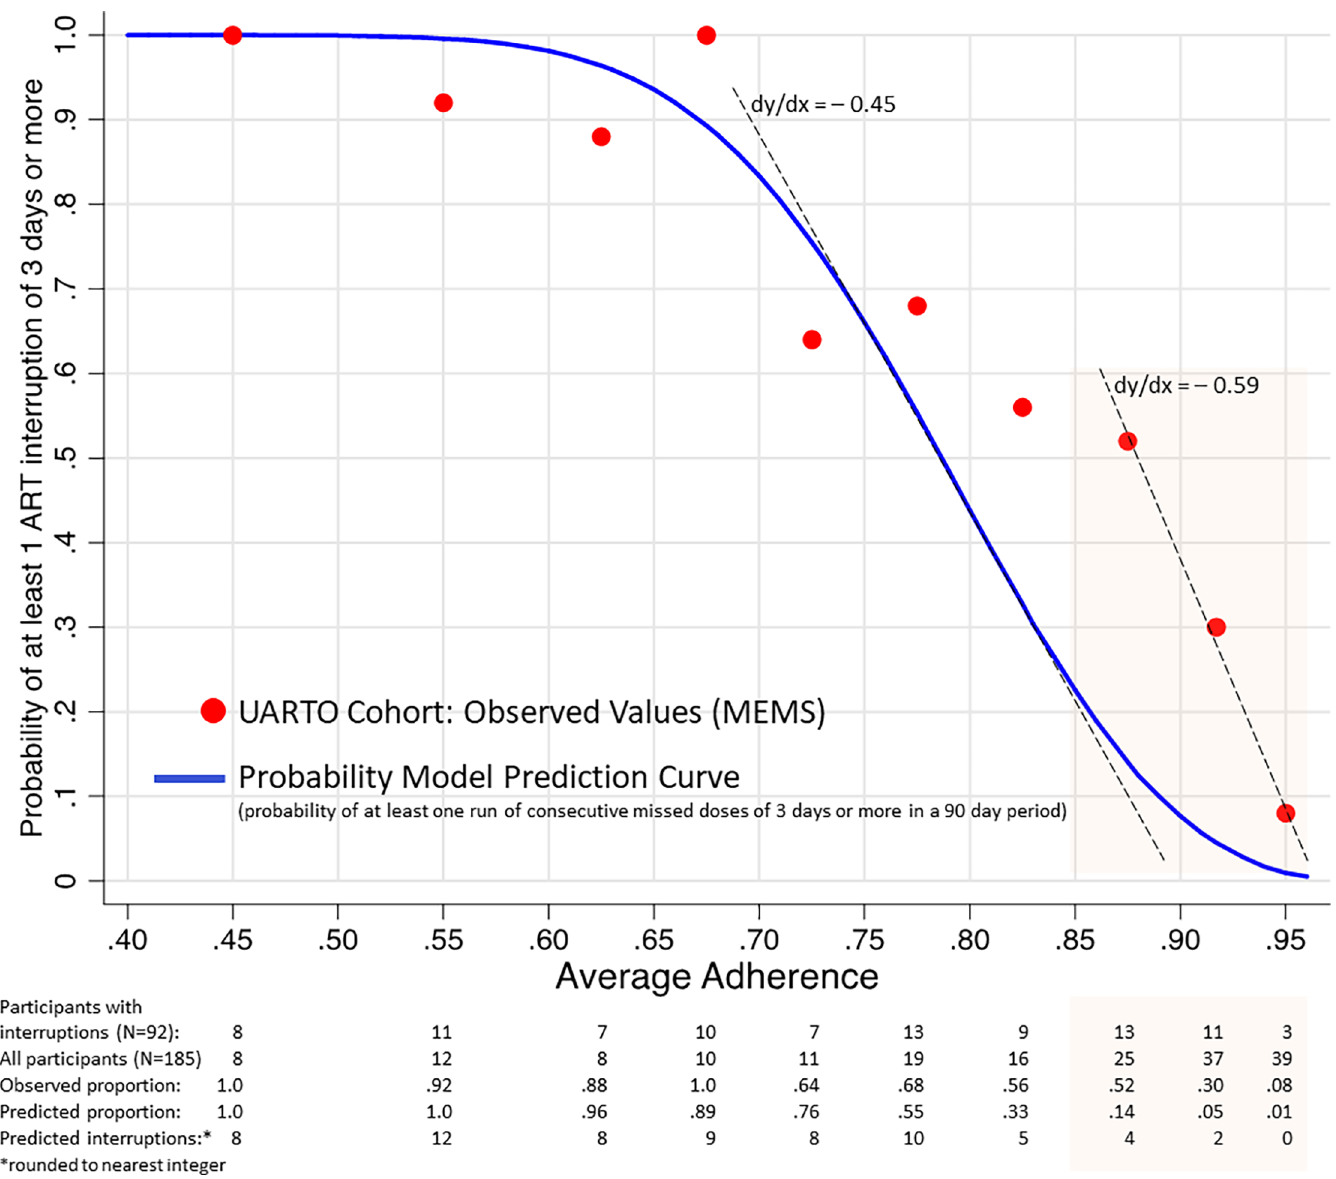
Fig 1. Comparison of observed and predicted values of ART interruption by average